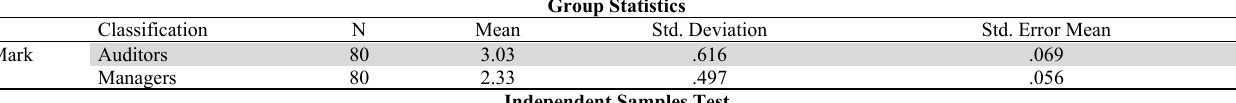
Evaluation of the impact of the professional associations on the application of the international financial reporting standards for SMEs from the perspective of auditors and